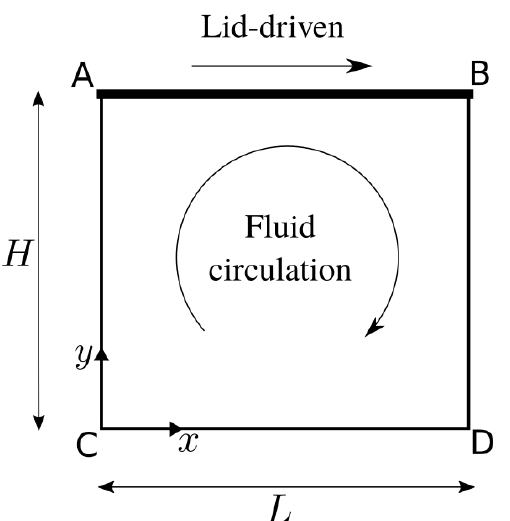
Figure 5. Illustration of lid-driven cavity. The parabolic velocity profile is imposed on the top. The aspect ratio is defined as Λ ≡ H / L